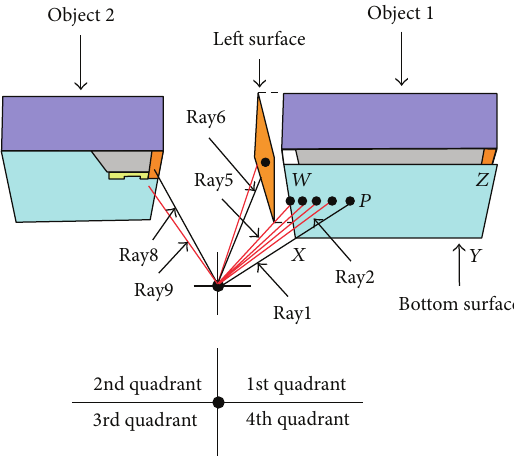
Figure 10: Illustration of the minimization of ray and object surface intersection tests based on prior